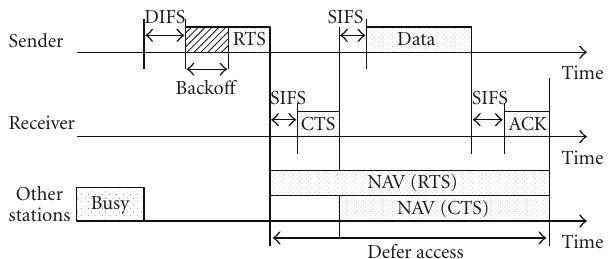
Figure 8: IEEE 802.11 DCF channel access coordination with RTS/CTS and NAV mechanisms.